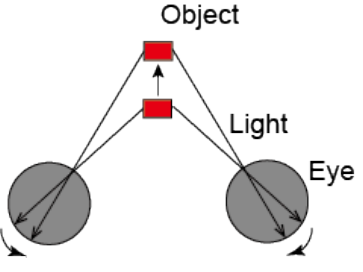
Figure 2. Projection of objects in the